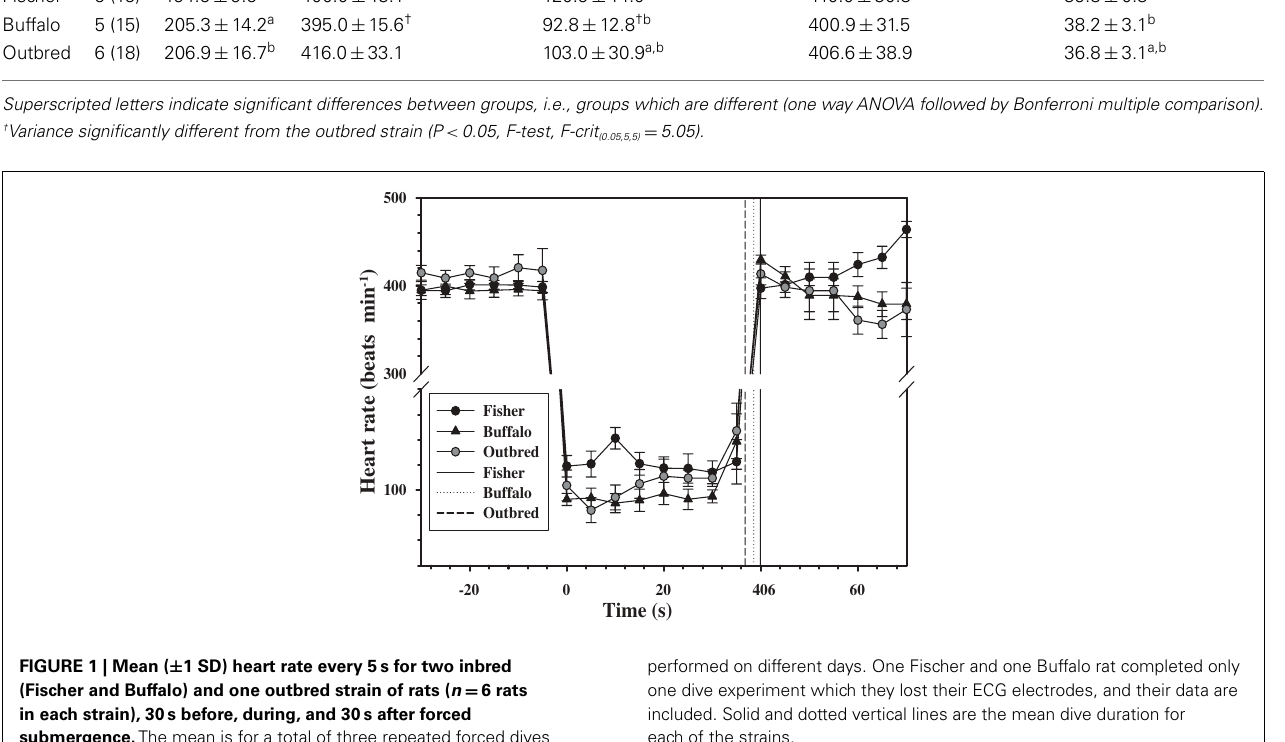
performed on different days. One Fischer and one Buffalo rat completed only one dive experiment which they lost their ECG electrodes, and their data are included. Solid and dotted vertical lines are the mean dive duration for each of the